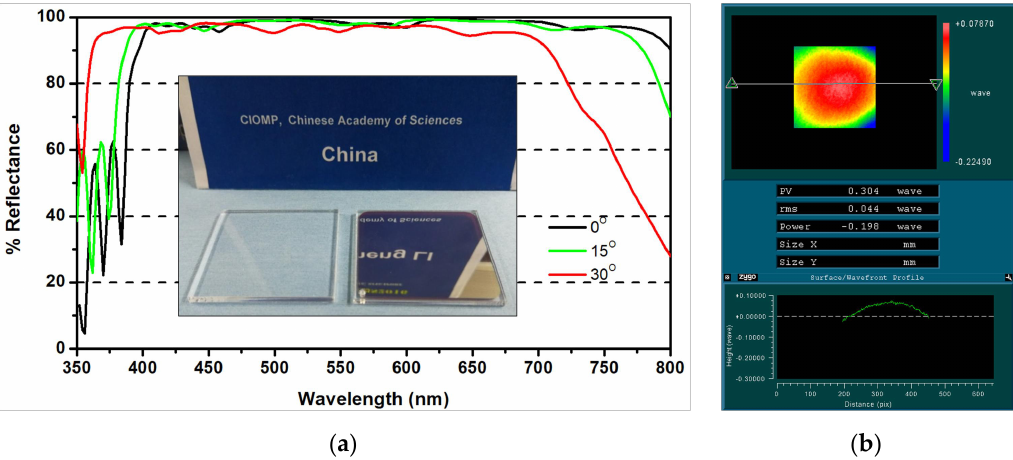
Figure 5. ( a ) Measured reflectance of the optimized 30 layers HR coating and samples image (left is PMMA substrate, right is HR coating sample); ( b ) Surface shape test result measured by the interferometer.